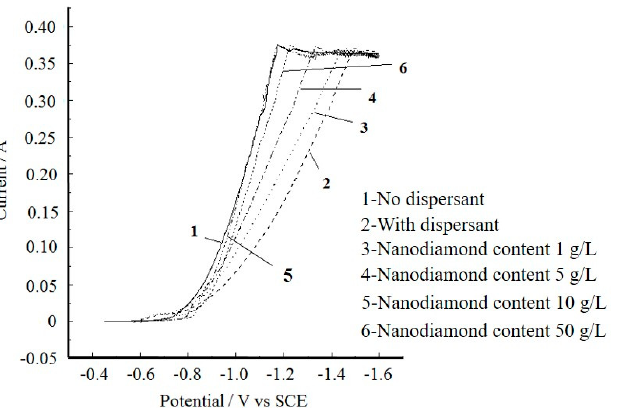
Figure 4. Polarisation curves of different cathode diamond concentrations in solution.